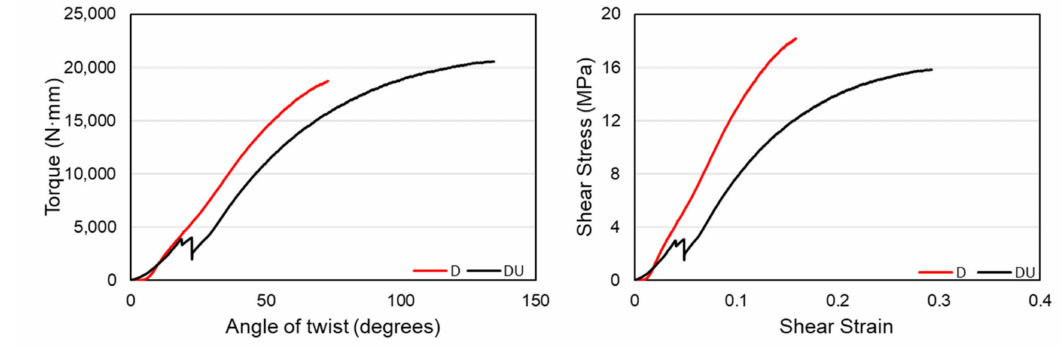
Figure 15. Comparison of torque-twist and shear-stress-strain curves between D and DU structures.